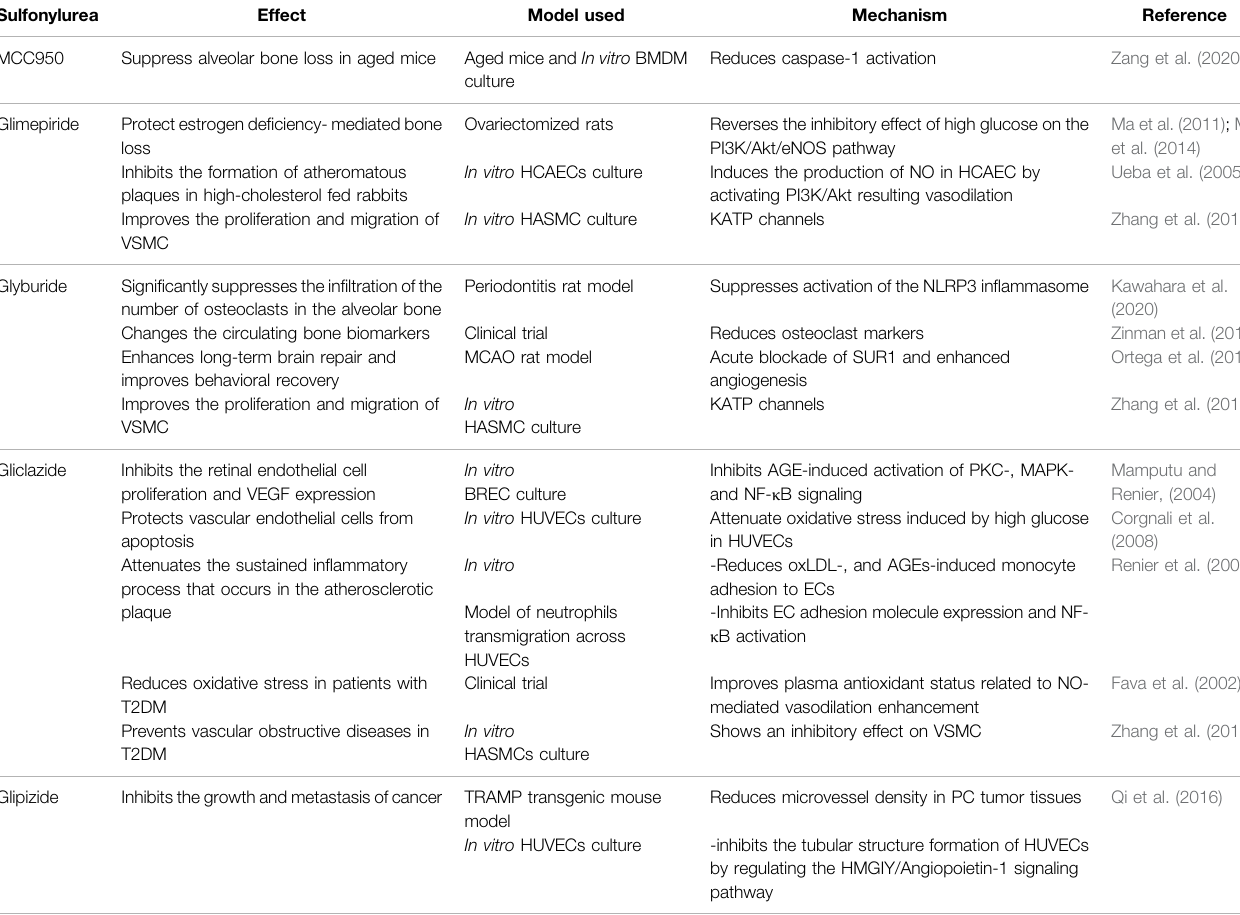
TABLE 2 | Sulfonylurea-mediated effects on bone metabolism and vascular functions.